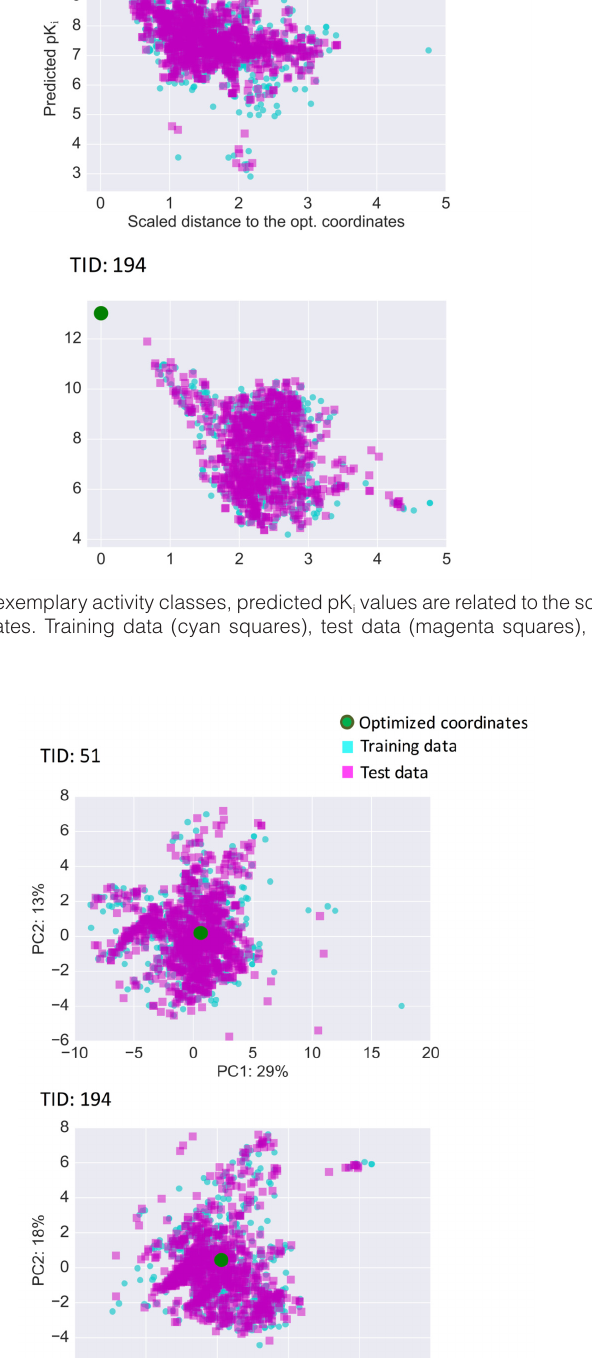
Figure 6. Projection of optimized coordinates. For the two activity classes from Figure 5, training data (cyan squares), test data (magenta squares), and optimized coordinates (green circle) were projected on a principal component (PC) plot derived from training data. For PC1 and PC2, contributions to data set variance are reported in